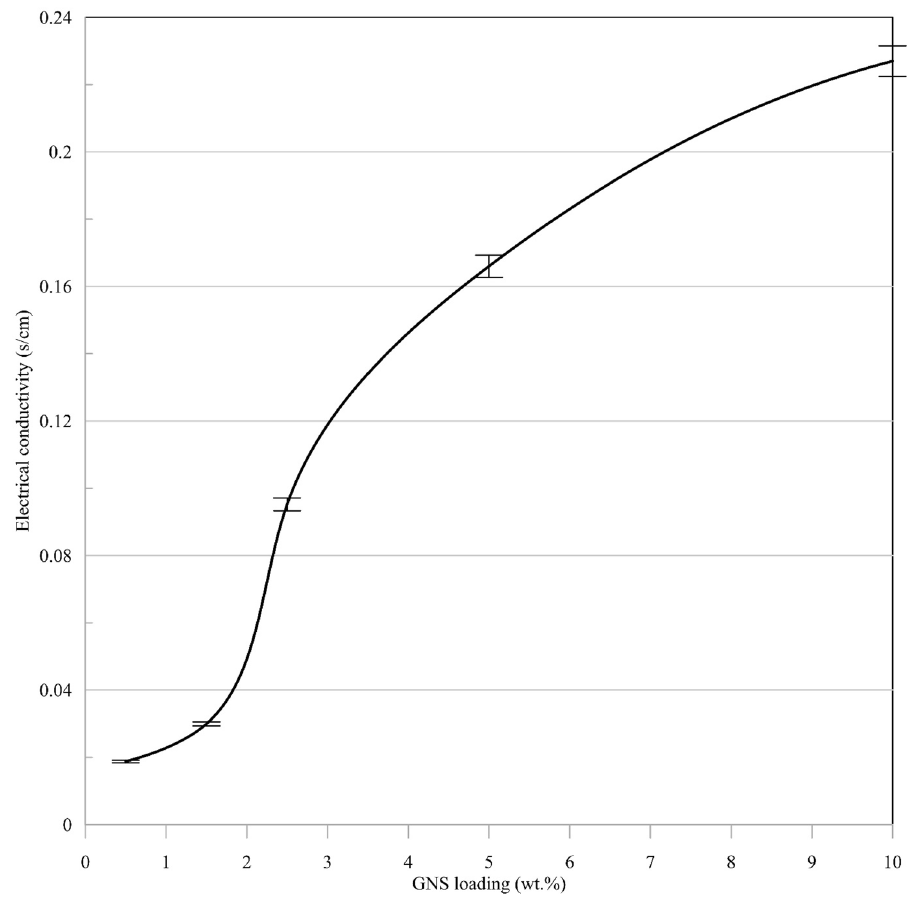
Fig. 6 Electrical conductivity of coated fabric as a function of GNS loading measured at room temperature (300